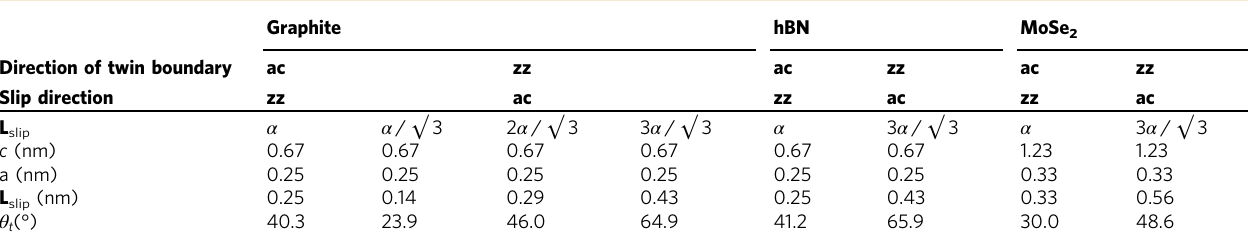
Table 1 Parameters calculated from literature X-ray crystallography structures for armchair and zig-zag twin boundaries in graphite, hBN and MoSe 2 Graphite hBN MoSe 2 Direction of twin boundary